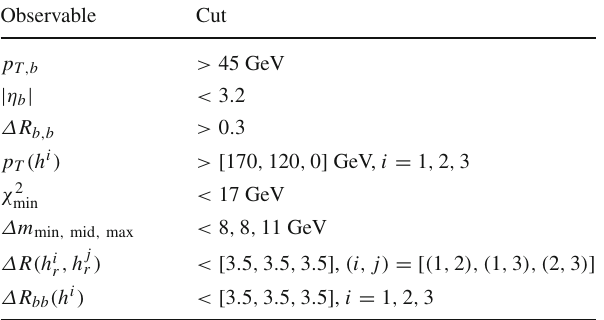
Table 2 The cuts that comprise the phenomenological analysis at hadron